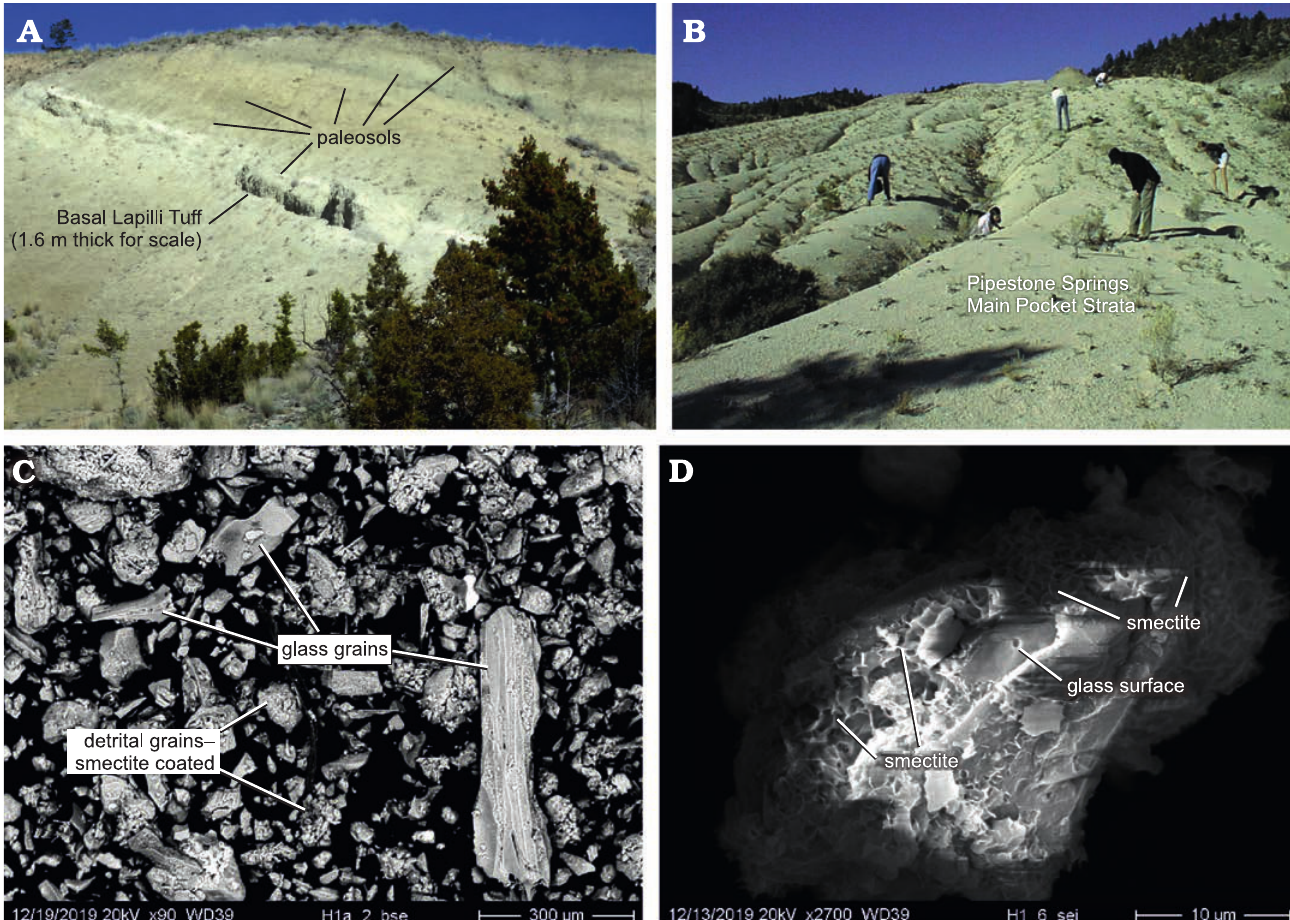
Fig. 5. Field and SEM appearance of Pipestone Spring section strata and sediments. A . Pipestone Springs reference section’s lower strata, including the 37.50±0.02 Ma basal lapilli tuff and overlying paleosol horizons. The basal lapilli tuff is 1.6 m thick for scale. B . A massive, white, 15 m-thick silty mud- stone unit constitutes the upper-most part of the Pipestone Springs reference section and the Pipestone Springs south section. This massive unit is the locus of PSMP fossil vertebrate collections, including the localities MV 5811, CM 3575, and RAM V200301 occurring in the Pipestone Springs reference section, and locality MV 5810, CM 3576, and RAM V200322 located in the Pipestone Springs south section. Students, with an average height, are sur- face collecting fossil vertebrates from the PSMP strata. C . Backscattered SEM image showing fresh to altered glass and detrital grains that display grain morphology ranging between rounded and angular. Sample location is H1a_2 as shown in the stratigraphic column of Fig. 4, sampled from the Pipestone Springs reference section’s 36.00±0.20 Ma reworked tuff. The coexistence of these grains and mixed grain morphology indicates sediment mixing. D . SEM micrograph of glass shard heavily coated by smectite. Many grain samples from Pipestone Springs strata are heavily coated by smectite which is the dominant clay mineral in these rock units. Sample location is H1_6, shown in the stratigraphic column of Fig. 4, sampled from the Pipestone Springs reference section’s 36.00±0.20 Ma reworked